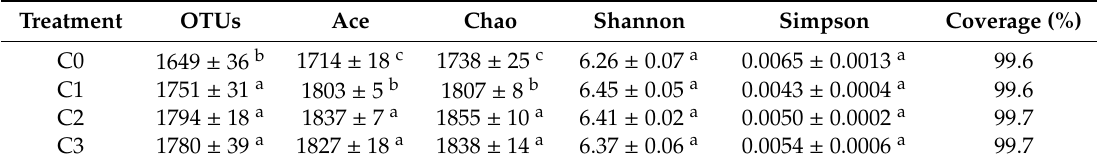
Table 3. Illumina MiSeq sequencing of bacterial data and bacterial community diversity indices (at 97% sequence similarity) based on 16S rRNA gene.